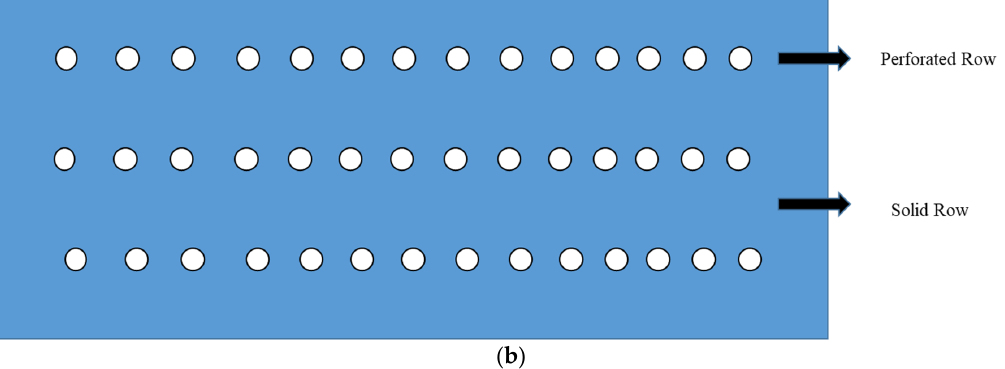
Figure 1. ( a ) Flat UTC model configuration (unit: m)—Computational domain; ( b ) model of perfo- rated and solid rows arrangement. Table 1. Details of Boundary States.